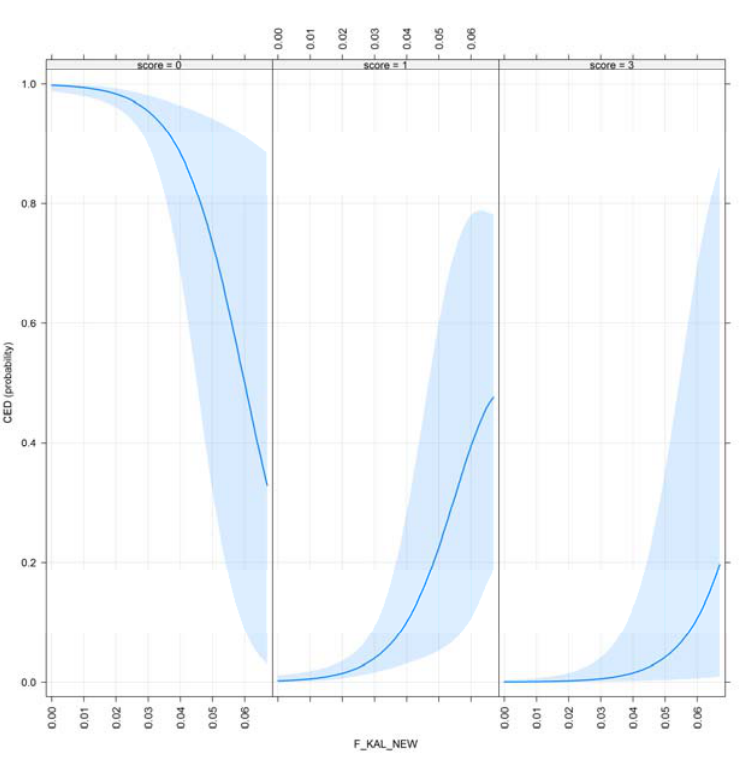
Figure 8. Effect plot of F_ KAL for CED. Figure 8. E ff ect plot of F_ KAL for CED.